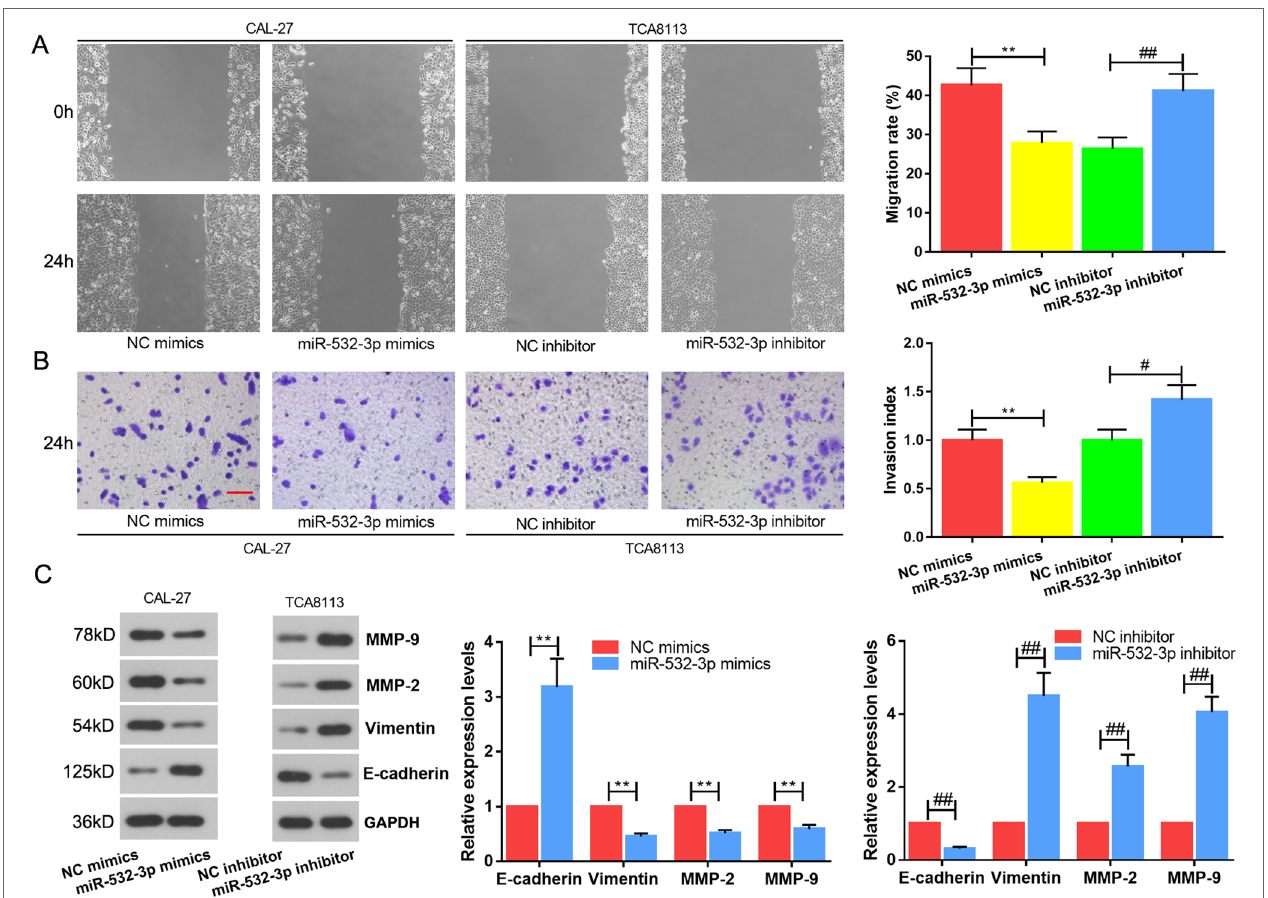
FIGURE 3 | Overexpression of miR-532-3p suppresses migration and invasion of TSCC cells in vitro . Wound healing (A) and transwell (B) assays of TCA8113 and CAL-27 cells after transfection. (C) EMT protein analysis. E-cadherin, vimentin, MMP-2 and MMP-9 were detected by western blot. Scale bar = 100 μM. **p < 0.01 vs. miR-532-3p mimics; #p < 0.05, ##p < 0.01 vs. miR-532-3p